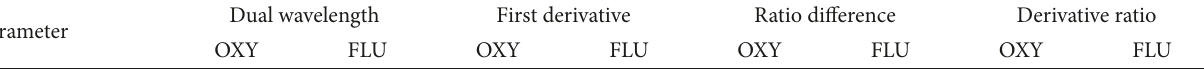
Table 1: Assay validation sheet of the proposed methods for the determination of Oxytetracycline HCl and Flunixin Meglumine.